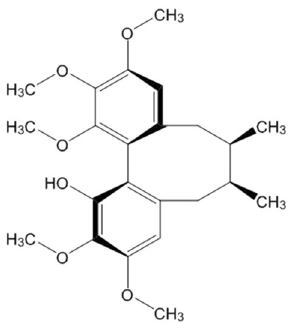
Figure 1. Chemical structure of Schisanhenol.